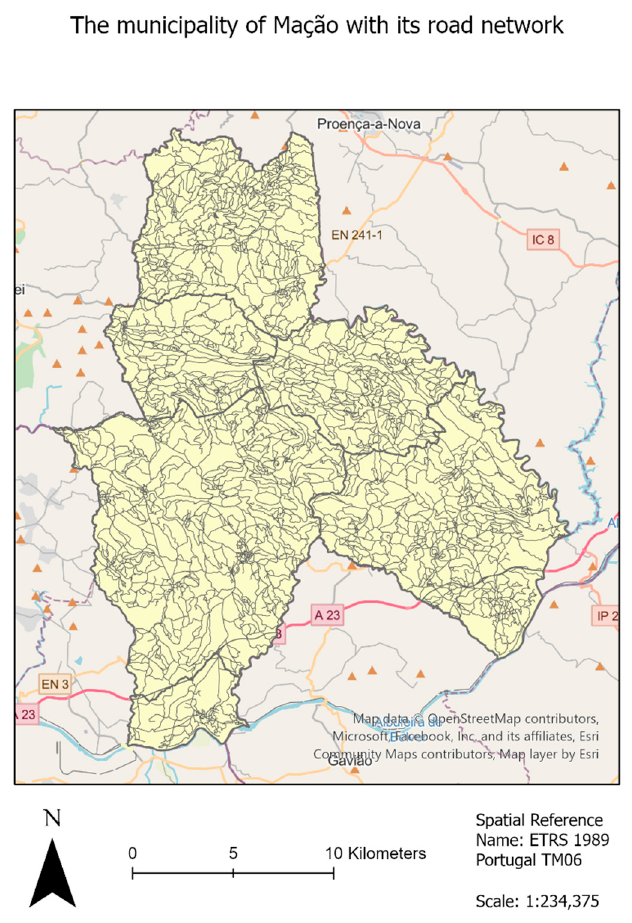
Figure 2. The road network of the Mação municipality, with an area of approximately 400 km 2 . Sixty-one high-resolution orthorectified aerial images provided by the Direção Geral do Território (DGT—[25]) were used in this research. They were in Tagged Image File Format (TIFF), with an intensity resolution of 8 bits in RGBI (Red, Green, Blue, and Infrared channels) and a spatial resolution of 0.25 m. Only the RGB channels were used, with each aerial image presenting 16,000 × 10,000 pixels covering an area of 4 km by 2.5 km. The associated ground truth images were created manually, overlaying a black layer on top of the aerial image and highlighting the rural roads in white. This process applied several aerial images, creating multiple pairs of aerial images with their